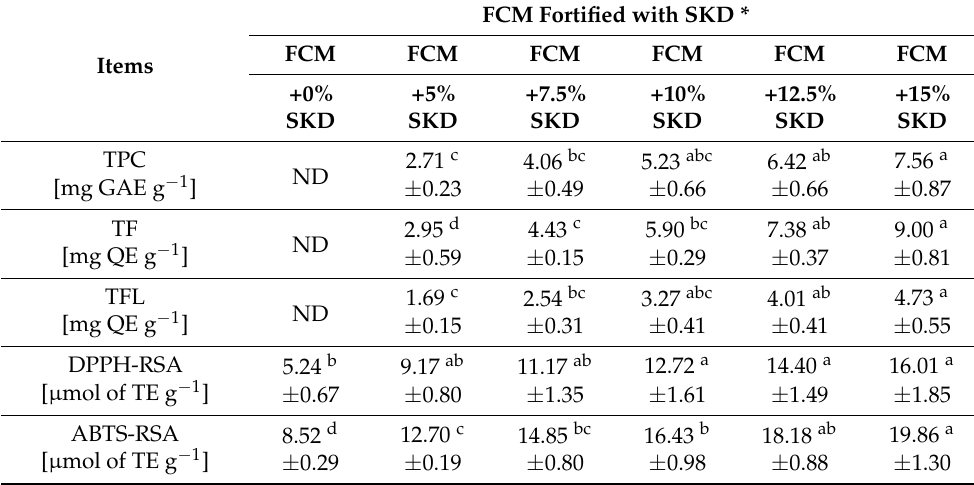
Table 4. Total phenolic, total flavonoids, total flavonols contents, and relative antioxidant capacity of fermented camel milk (FCM) and FCM fortified with Sukkari date (SKD), (mean ± SE), n = 6.